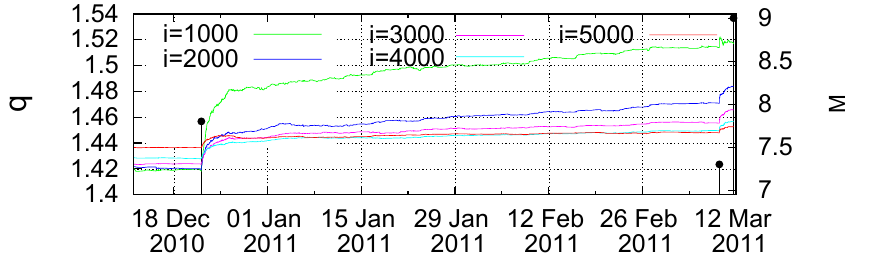
Figure 20. Almost three-month excerpt of Figure 19 after the occurrence of the M 7.8 EQ on 22 December 2010. The vertical lines ending at black solid circles show the magnitudes ( M ≥ 7) of EQs, which are read in the right scale. Taken from Ref. [87].